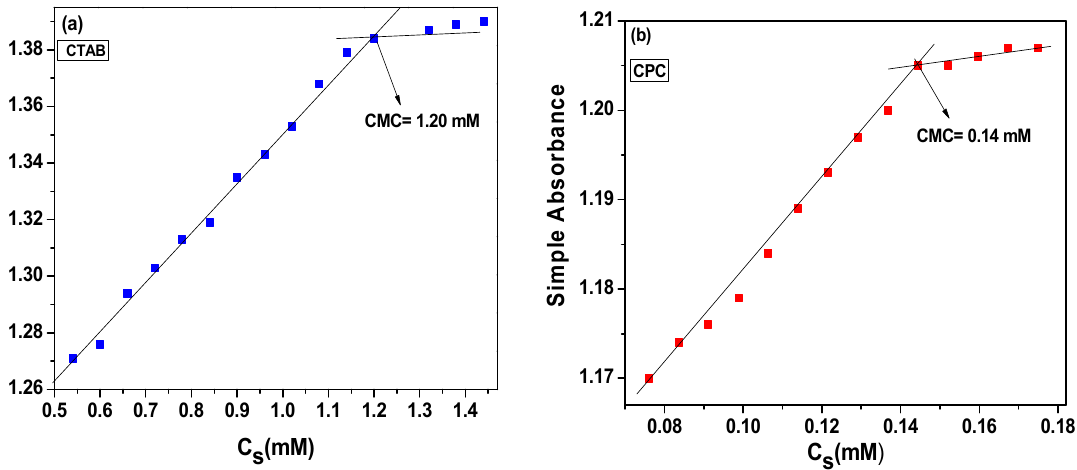
Figure 2. ( a ) Simple absorption of NGB as a function of concentration of CTAB, ( b ) simple absorption of NGB as a function of concentration of CPC.